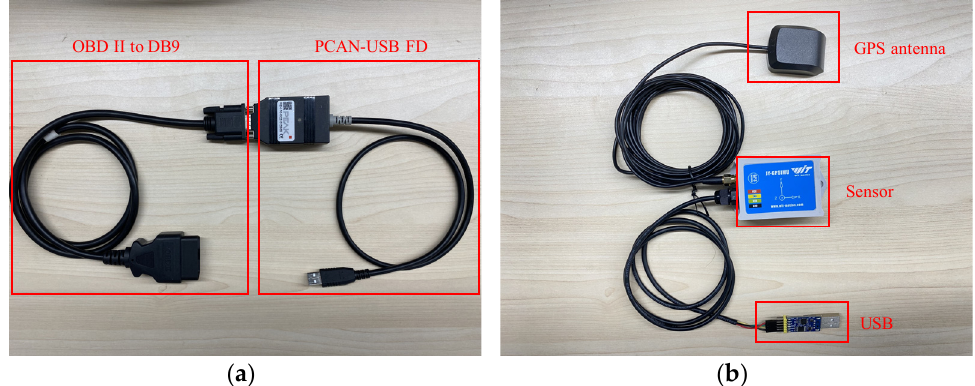
Figure 6. Data acquisition equipment: ( a ) OBD-II data collection equipment; ( b ) Vehicle behavior sensor. Table 2. Sensor locations and associated physical